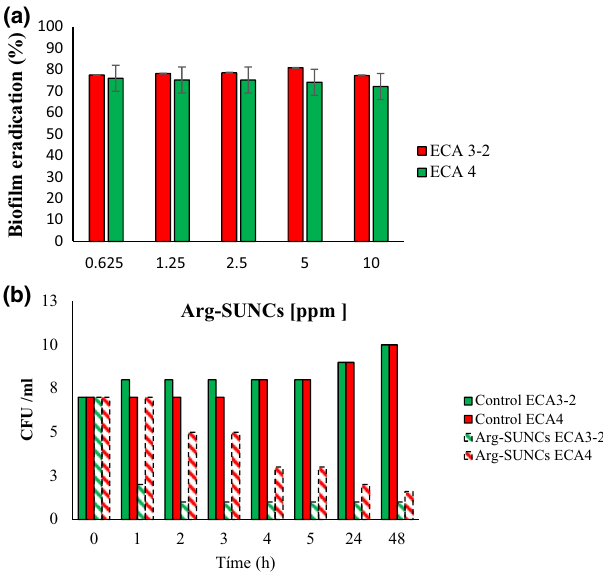
Figure 2. ( a ) Percentage of eradication of biofilm formed by K. pneumoniae (ECA3-2) and E. roggenkampii (ECA4) and by using different concentration of Arg-SUNCs. ( b ) Time-kill kinetics for the strain ECA4 and ECA3-2 treated with 5 ppm of